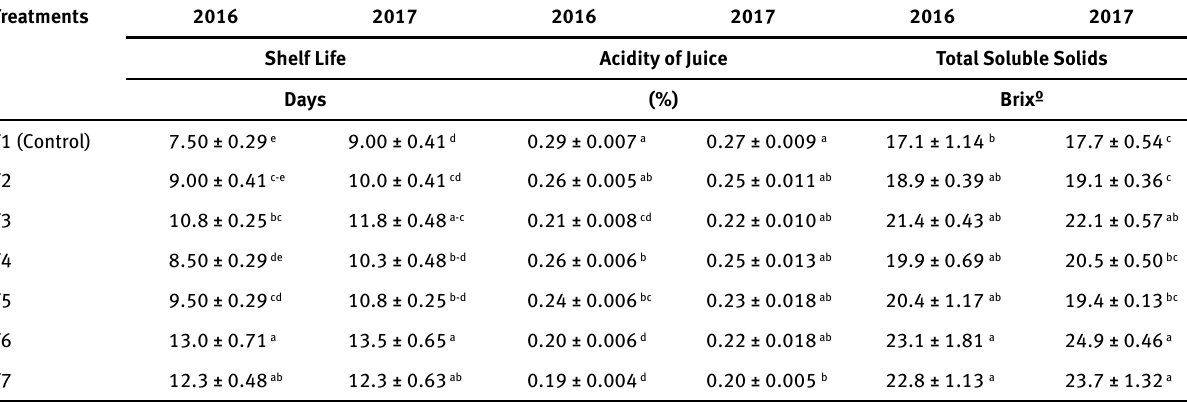
Table 3. Effects of foliar application of variable sources of Ca and K with Boric acid on shelf life, acidity of juice and total soluble solids of SB Chaunsa fruit Treatments